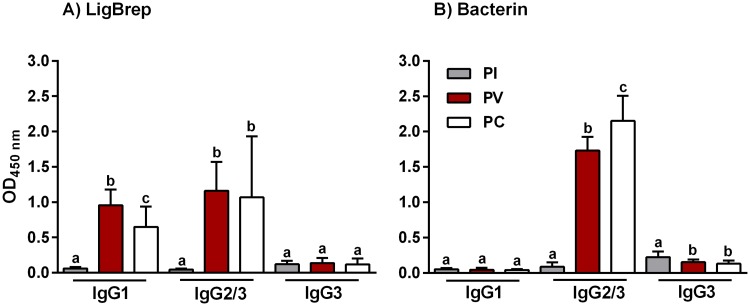
IgG subclasses induced by vaccination with LigB(131–645).IgG subclasses were characterized using ELISAs to determine antibody levels in hamsters immunized with A) rLigB(131–645)/AH or B) bacterin vaccine, see Table 1. Pre-immune (PI), post-vaccination (PV) and post-challenge (PC) serum samples were collected and characterized with anti-hamster IgG1, IgG2/3 or IgG3 conjugates. The mean OD ± standard deviation (vertical bars) from three independent experiments are shown. Significance was determined by one-way ANOVA (Tukey multiple comparison) analysis and the presence of lower case letters, where different, indicates a significant difference (P < 0.05) between samples.